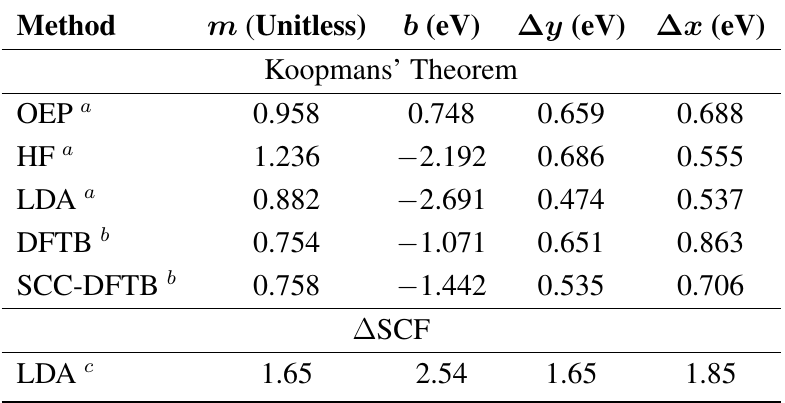
Table 3. Fitting data for outer valence IPs: y = mx + b , where x is the experimental IP and y is the calculated IP, both in eV. HF, Hartree–Fock; OEP, optimized effective potential; LDA, local density approximation; DFTB, density-functional tight binding (without self-consistent charge); SCC-DFTB, self-consistent charge